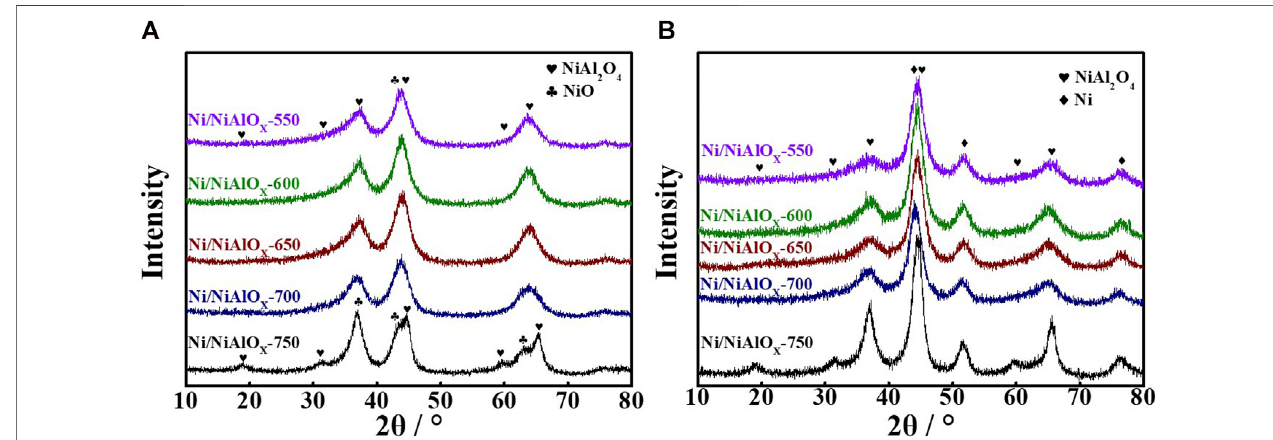
FIGURE 1 | Powder XRD spectra of Ni/NiAlO x catalysts after calcination (A) and reduction (B) at different temperatures.